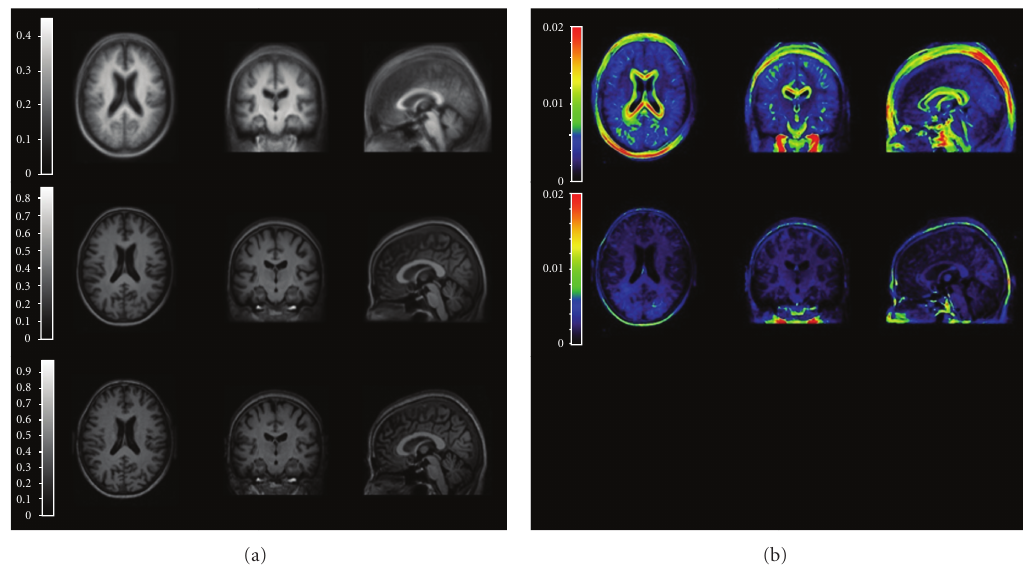
Figure 1: (a) (Left) Warping results: average of 22 subjects MRIs after linear registration only (top); average of 22 subjects after warping to common space (middle); MRI of common space subject (bottom). (b) (Right) Absolute voxel-to-voxel variance of unwarped (top) and warped (bottom) MRIs. Warping reduces average in-brain variance by 54% from linear registration